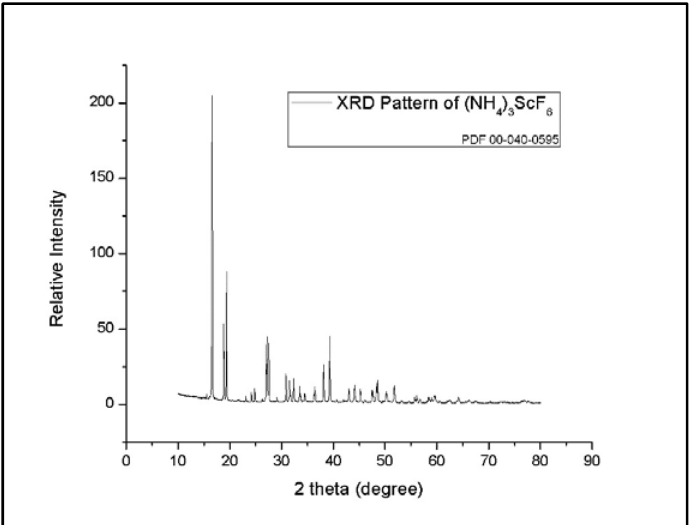
Figure 4. XRD pattern of the obtained (NH 4 ) 3 ScF 6 crystals.